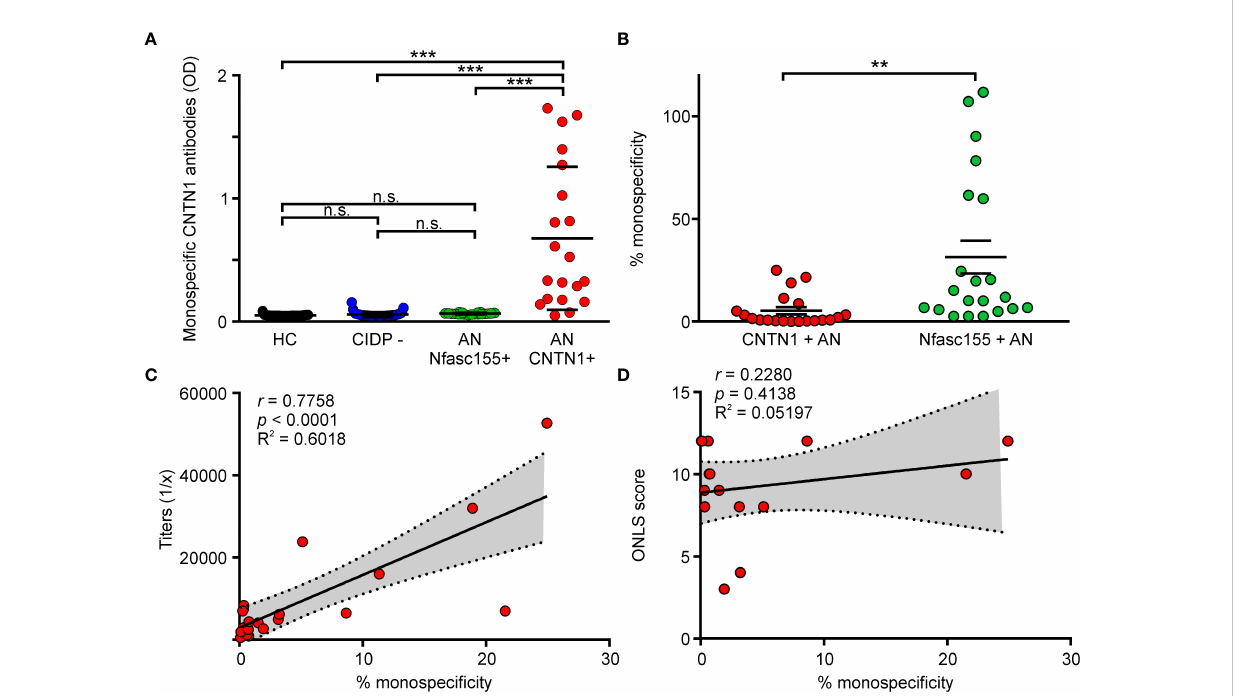
FIGURE 1 Fab-arm exchange occurs in patient with AN. (A) The capacity of serum antibodies to cross-link untagged CNTN1 with biotinylated CNTN1 was measured by sandwich ELISA in healthy controls (HC; n = 23), seronegative CIDP patients (CIDP -; n = 43), Nfasc155+ autoimmune nodopathy (AN Nfasc155 +; n = 21) and CNTN1+ autoimmune nodopathy (AN CNTN1+; n = 20). Antibodies from HC, seronegative patients or Nfasc155+ did not cross-link CNTN1. By contrast, CNTN1+ AN patients signi fi cantly cross-linked CNTN1 (*** P <0.001 by one-way ANOVA followed by Bonferroni ’ s post-hoc tests). (B) The percentage of monospeci fi c antibodies was calculated by interpolating the data from a calibration curve obtained with anti- CNTN1 IgG3. The percentage of monospeci fi c anti-CNTN1 antibodies in CNTN1+ AN (n = 20) was signi fi cantly smaller compared to the percentage of monospeci fi c anti-Nfasc155 antibodies in Nfasc155+ AN (n = 21) (** P <0.005 by unpaired two-tailed Student ’ s t tests). (C) The titers of anti- CNTN1 IgG4 correlated with the percentage of monospeci fi c CNTN1 antibodies calculated in each patient. (D) The clinical severity (ONLS) is plotted against the percentage of monospeci fi c antibodies in each patient (n = 16). No signi fi cant correlation was found. P value, Spearman ’ s correlation coef fi cient (r), R square (R 2 ) and 95% con fi dence band (dotted lines) are indicated on the graph. n.s.: non-signi fi cant, ONLS: Overall